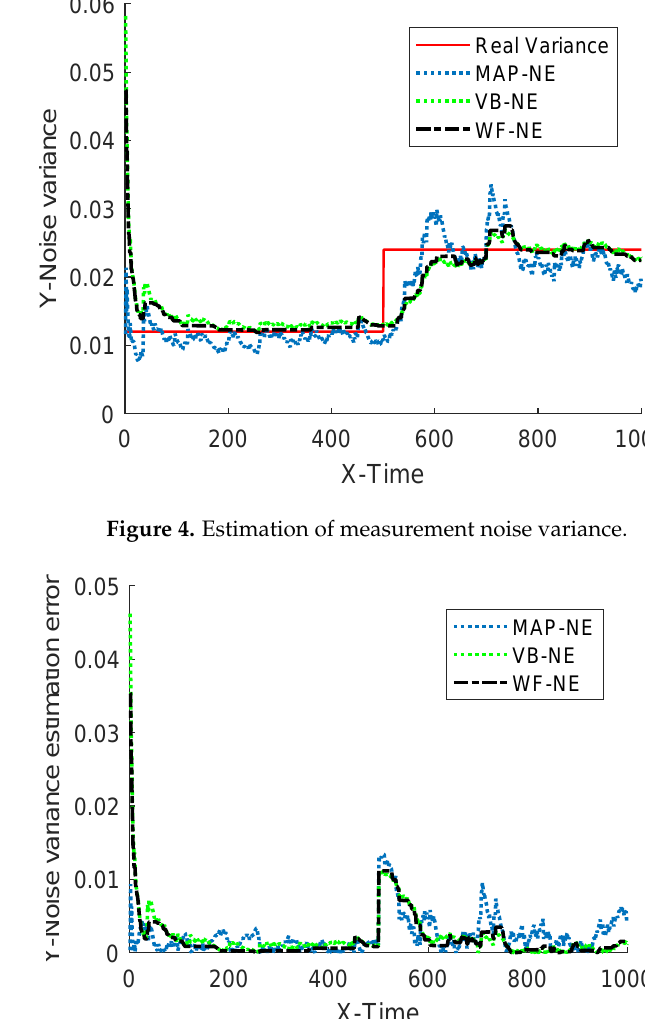
Figure 3. Absolute estimation error of measurement noise variance.